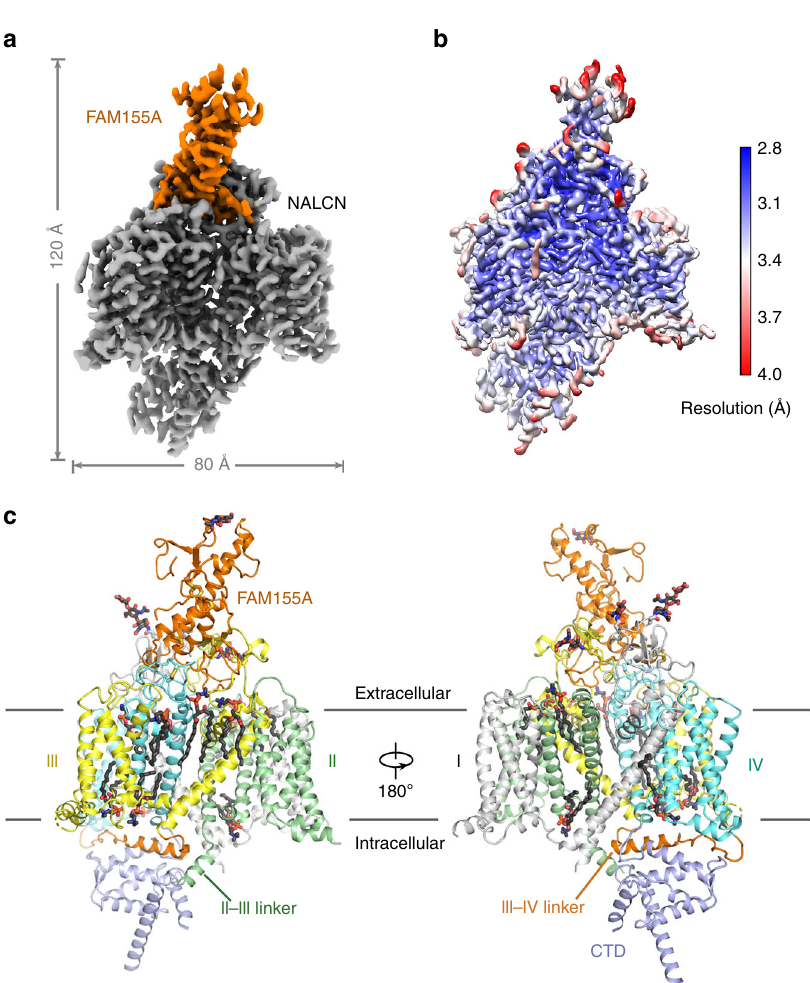
Fig. 1 Cryo-EM structures of human NALCN in complex with FAM155A. a Cryo-EM map of human NALCN in complex with FAM155A. NALCN and FAM155A are colored gray and orange, respectively. The map was contoured at 0.8 threshold level in ChimeraX 70 . b Local resolution map estimated by cryoSPARC 52 and generated in Chimera 57 . c Overall structure of the NALCN-FAM155A complex presented in two side views. The protein structure is shown in cartoon. NALCN is domain colored with repeats I, II, III, IV, and the CTD in light gray, green, yellow, cyan, and slate, respectively. The III-IV linker and FAM155A are colored orange. Lipid molecules and the sugar moieties at the glycosylation sites are shown as sticks. The color schemes are applied in all fi gures. All structure fi gures were prepared with PyMOL 71